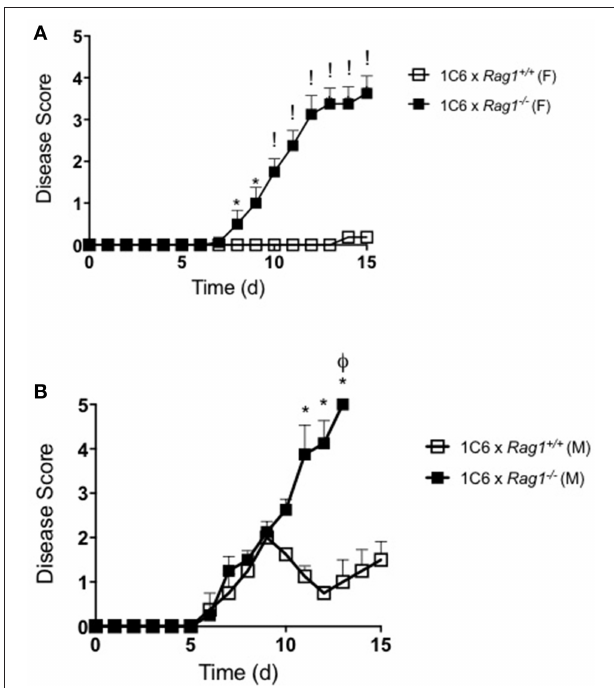
FIGURE 4 | 1C6 × Rag1 − / − mice develop severe MOG [35 − 55] -driven EAE. 1C6 (male, n = 4; female, n = 5) and 1C6 × Rag1 − / − (male, n = 4; female, n = 5) mice were actively immunized with MOG [35 − 55] and were monitored for signs of EAE. (A) female, (B) male. * p < 0.05; ! p < 0.001, two-tailed Mann-Whitney U test. φ indicates that all mice in the experimental group attained ethical endpoints. Representative of three